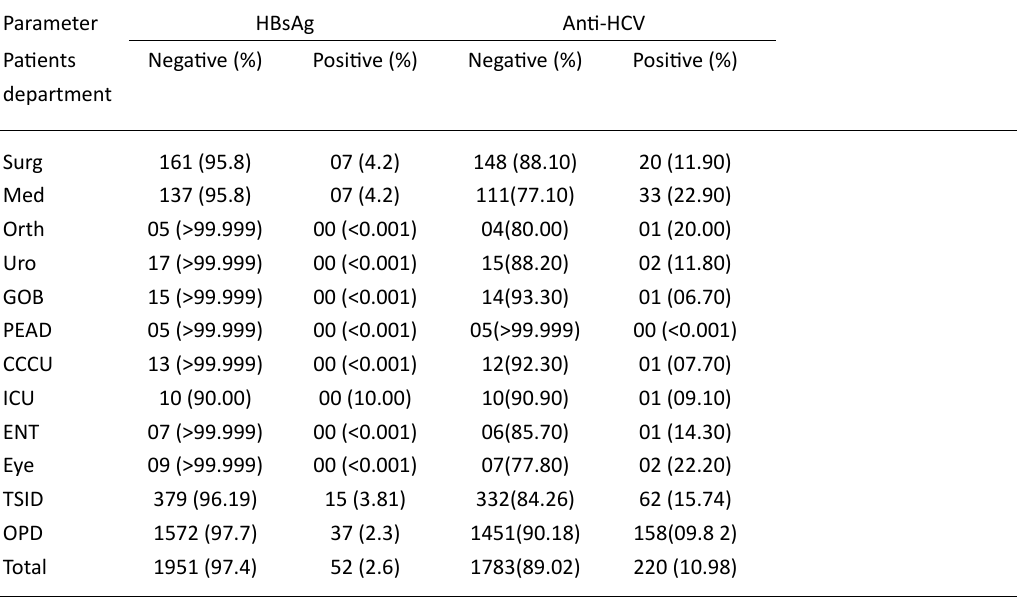
Table 2. Department wise Observed positivities of HBsAg and anti HCV.